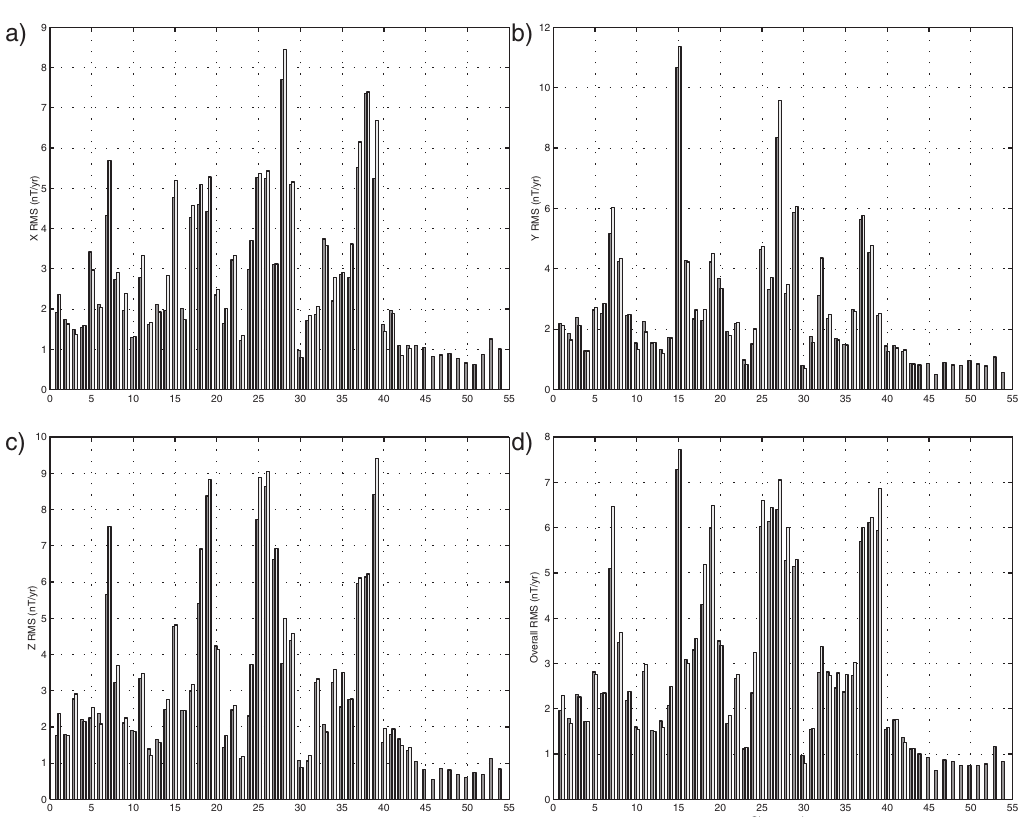
Fig. 5a-d. The X , Y , Z and the overall rms misfit at each observatory locations from the regional, EU_MIX model (black) and the global, CM4 model